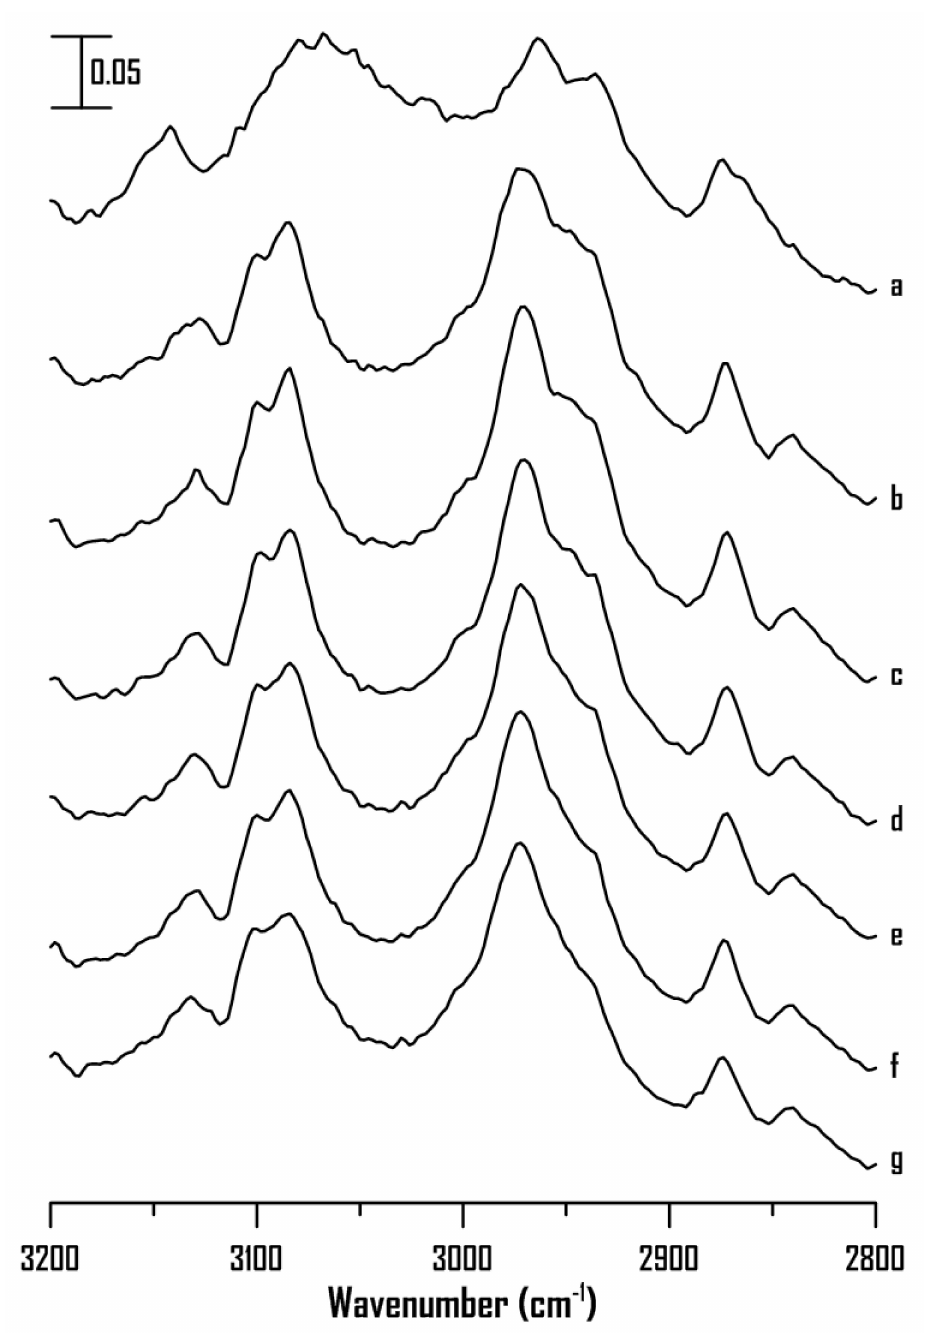
Figure 3. IR spectra of pure [BMIM]Br at ( a ) ambient pressure and ( b ) 0.4, ( c ) 0.7, ( d ) 1.1, ( e ) 1.5, ( f ) 1.8, and ( g ) 2.5